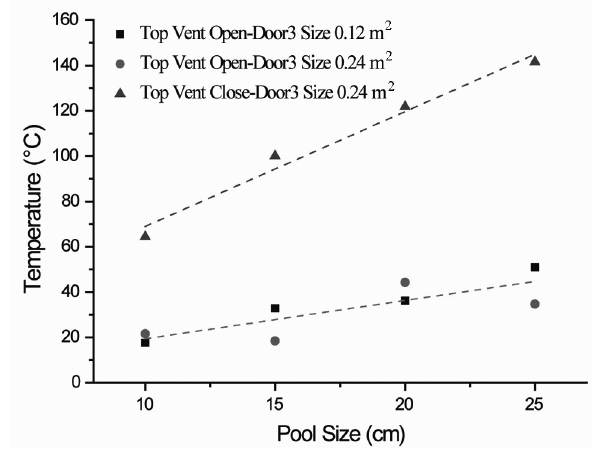
Fig. 9. The mean temperature of the upper hot gases (0.9 m height) in the compartment